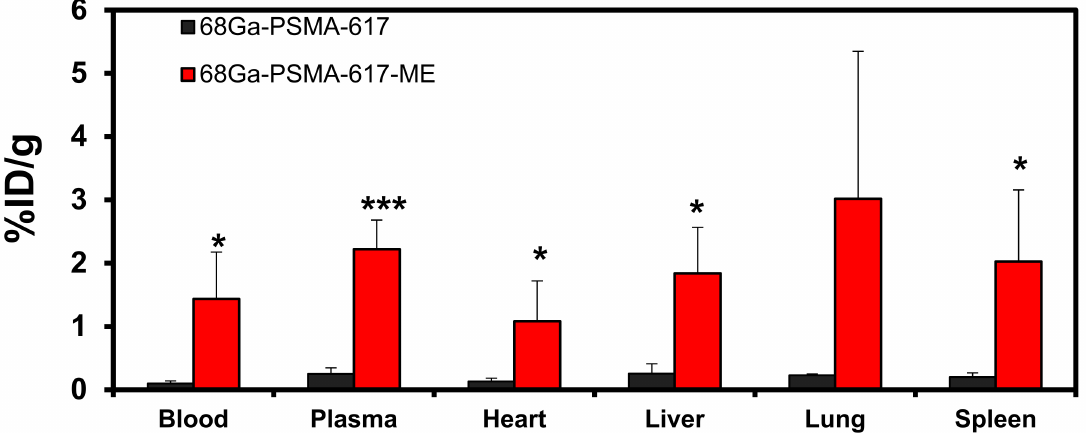
Figure 3. Ex vivo biodistribution (%ID/g) of [ 68 Ga]Ga-PSMA-617 (black) and [ 68 Ga]Ga-PSMA-617-ME (red) in blood and prefunded organs at 120 min after intravenous injections. Radioactive organ samples and radioactivity standards were measured using high-performance gamma counting. Results are expressed as mean ( ± SEM; n = 4). * P < 0.05; *** P <